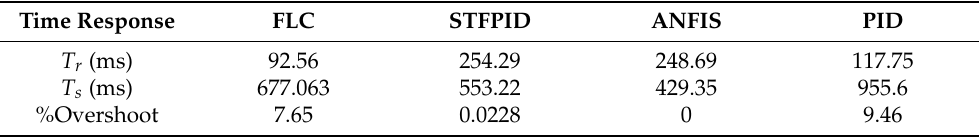
Table 6. Time-response characteristics comparison of depth